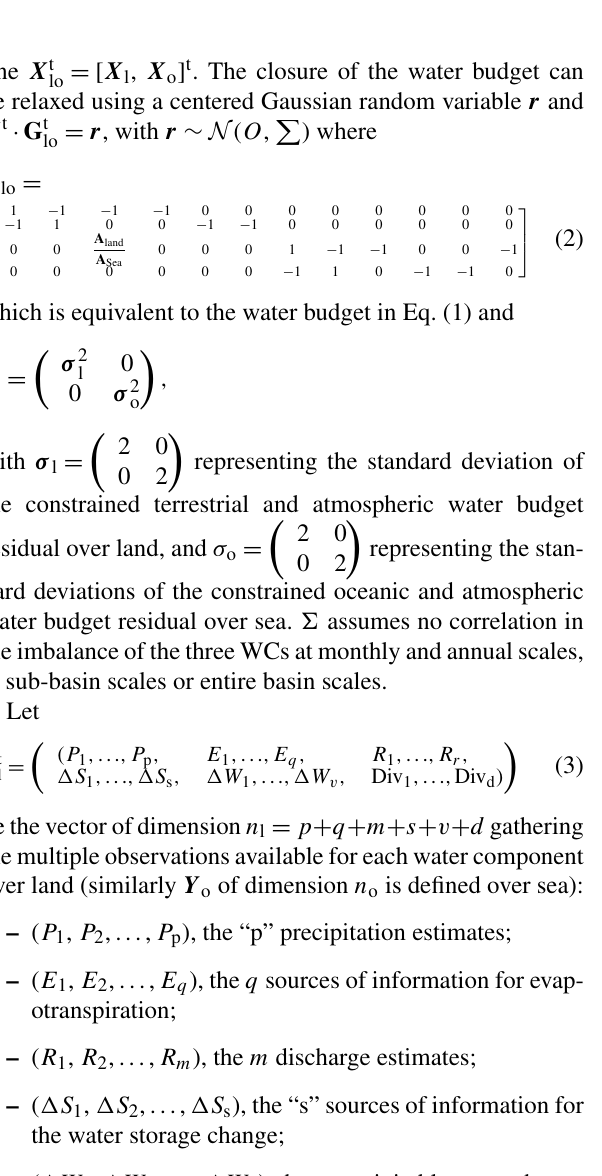
Table 2. Comparison of the uncertainty specifications for terrestrial water components. The weights associated with a variable (computed as the ratio between the particular variable uncertainty with respect to the sum of all the uncertainties σ 2